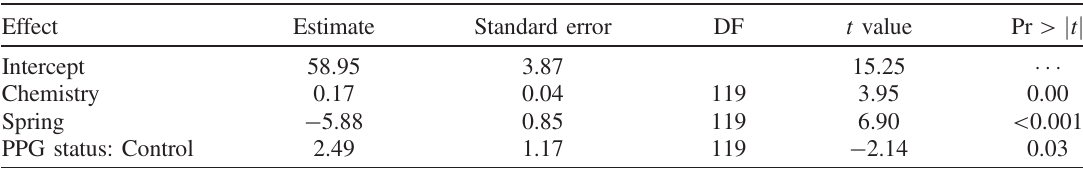
TABLE X. Stability model results for semester physics performance by year for SY 2015 – 2016. Note that the intercept represents the estimate for the control group in the